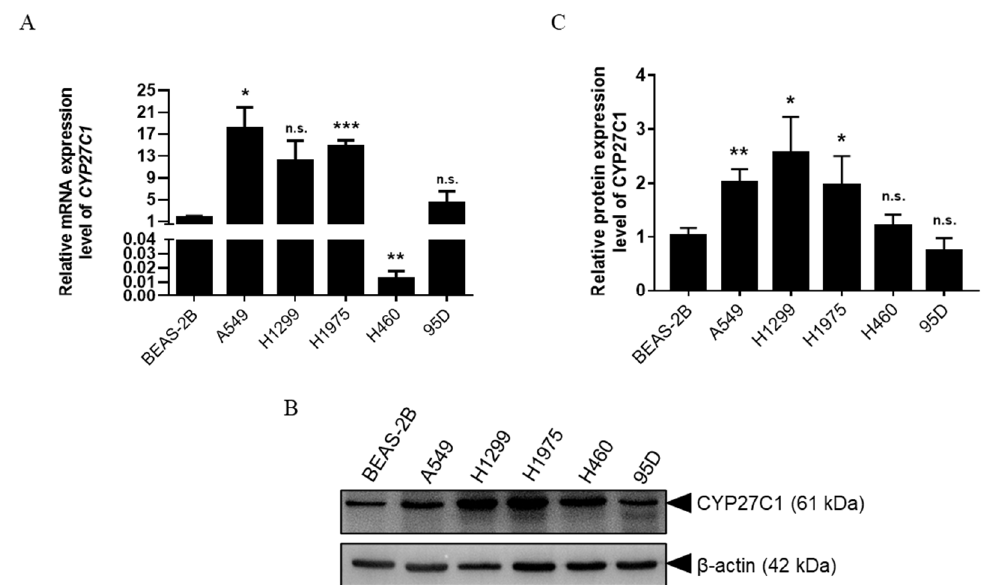
Figure 1. CYP27C1 expression in different human lung cancer cell lines. ( A ) Relative mRNA expres- sion levels of CYP27C1 in human bronchial epithelial BEAS-2B cells, and human lung cancer cells were detected by real-time fluorescence quantitative PCR. Results comparing BEAS-2B with other cell lines were analyzed by unpaired two-tailed T test. *, p < 0.05; **, p < 0.01; ***, p < 0.001; n.s., p > 0.05. ( B , C ) Protein expression level of CYP27C1 in BEAS-2B, and human lung cancer cells were detected by immunoblot analysis. Grey scales of the bands were analyzed by Gel-Pro ANALYZER. Results were analyzed by unpaired two-tailed T test comparing BEAS-2B with other cell lines. *, p < 0.05; **, p < 0.01; n.s., p > 0.05.